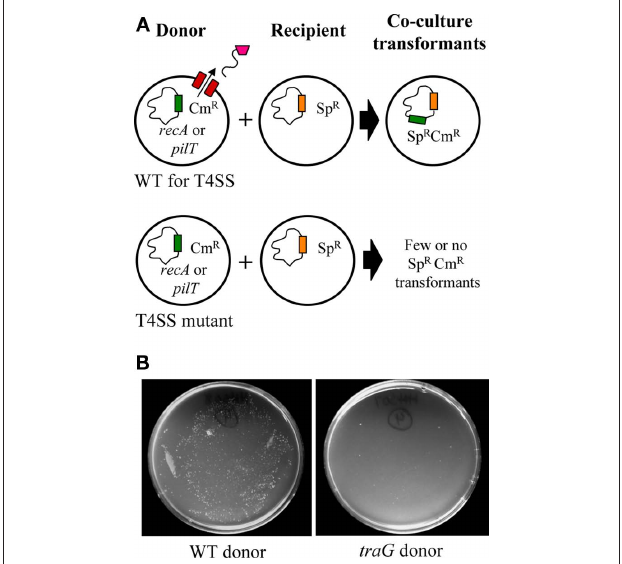
FIgure 2 | The gonococcal T4SS secretes chromosomal DNA active in natural transformation. (A) To assay for DNA secretion, a donor strain that is either wild-type (WT) or mutant for various T4SS genes is grown in co-culture with a recipient strain. The donor strain carries a chloramphenicol resistance marker (Cm R ), while the recipient is marked with spectinomycin resistance (Sp R ). The donor strain also carries a mutation in either pilT or recA to render it transformation-deficient and to ensure that it cannot act as a recipient. Following co-culture, bacteria are plated to double-selective plates to enumerate the number of Cm R Sp R transformants. (B) Co-culture with a wild-type donor yields significantly more Cm R Sp R colonies (left) compared to co-culture using a traG mutant